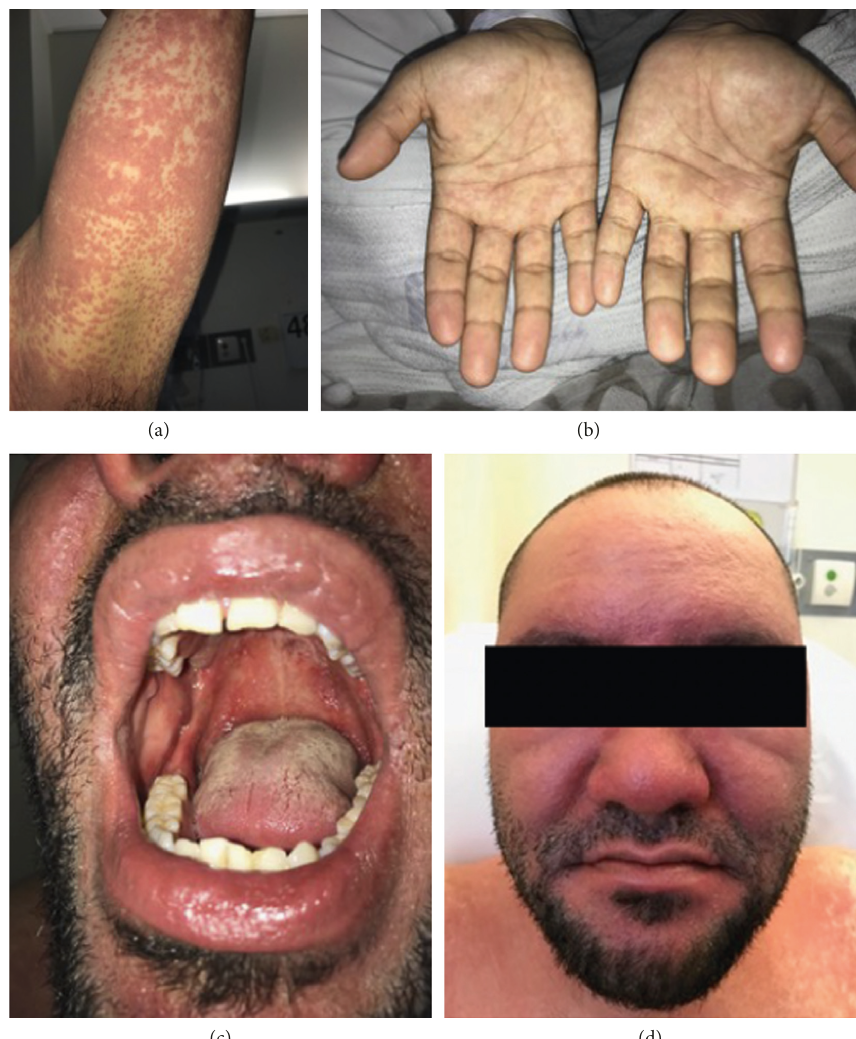
Figure 1: (a) Erythematous confluent macular and papular follicular eruption on his left upper arm. (b) The eruption involving the acral surfaces. (c) Marked facial swelling. (d) Oral mucosa ulcers.